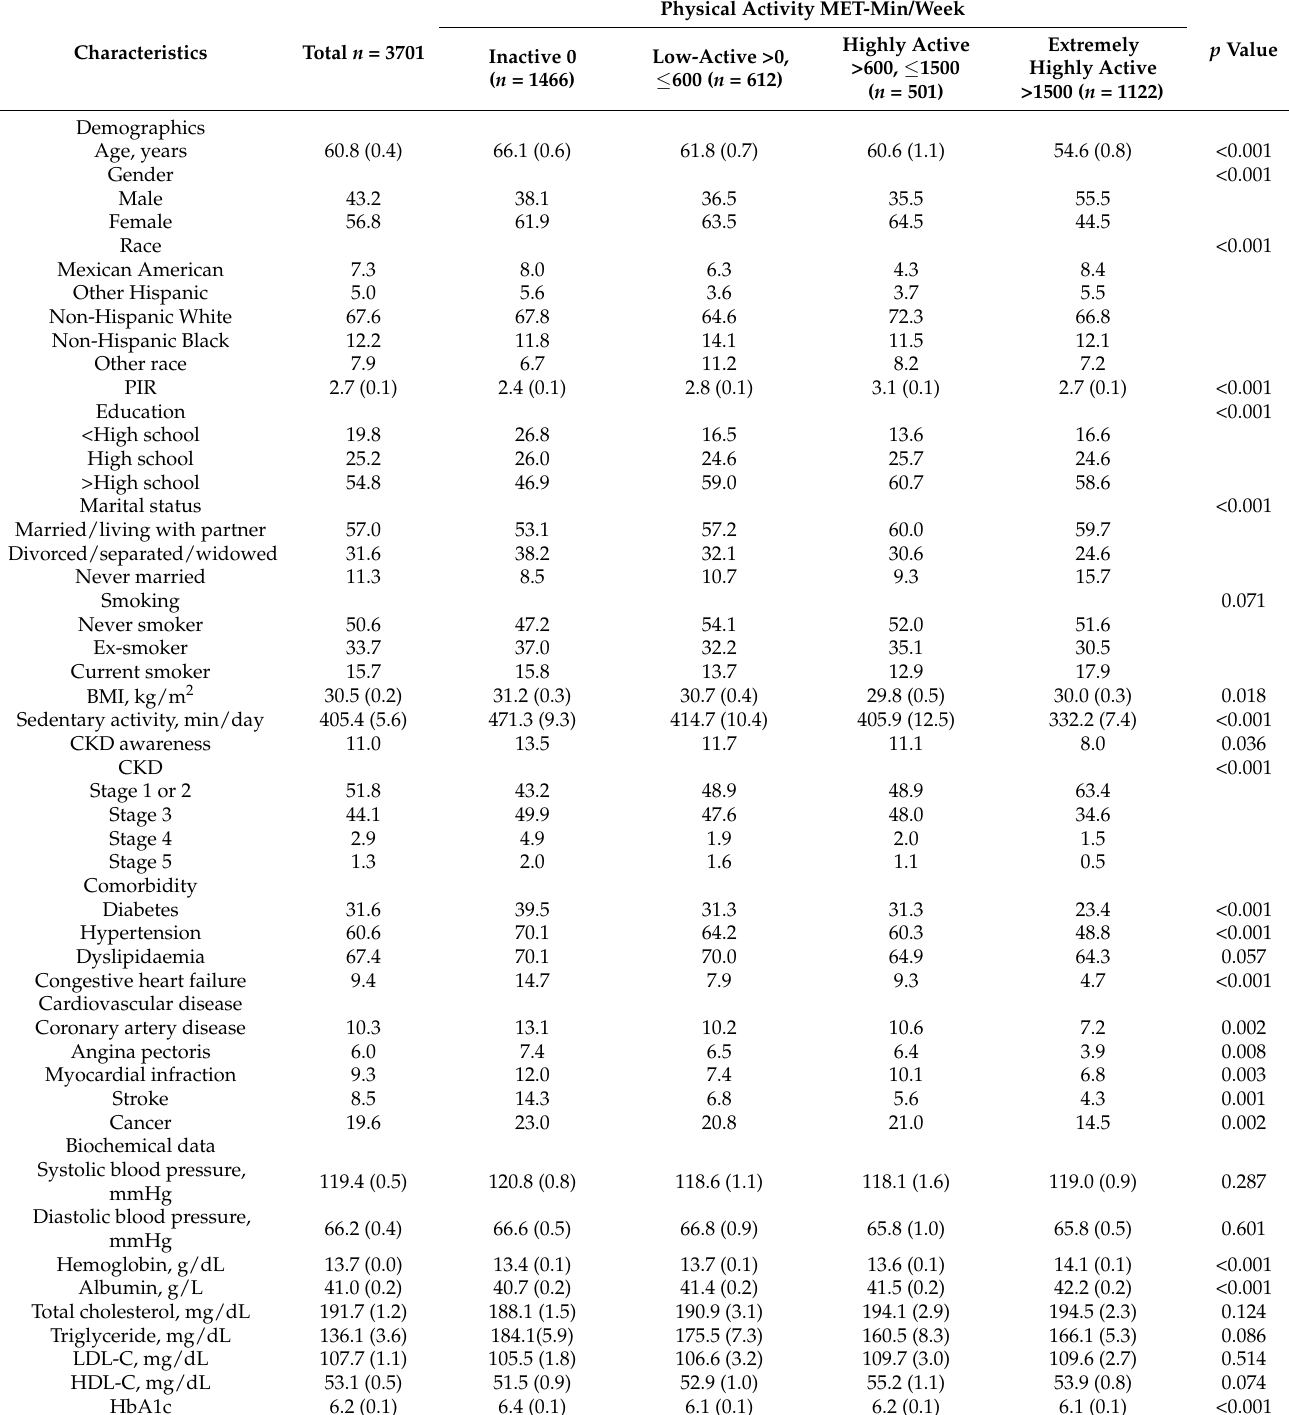
Table 1. Baseline characteristics of study participants by physical